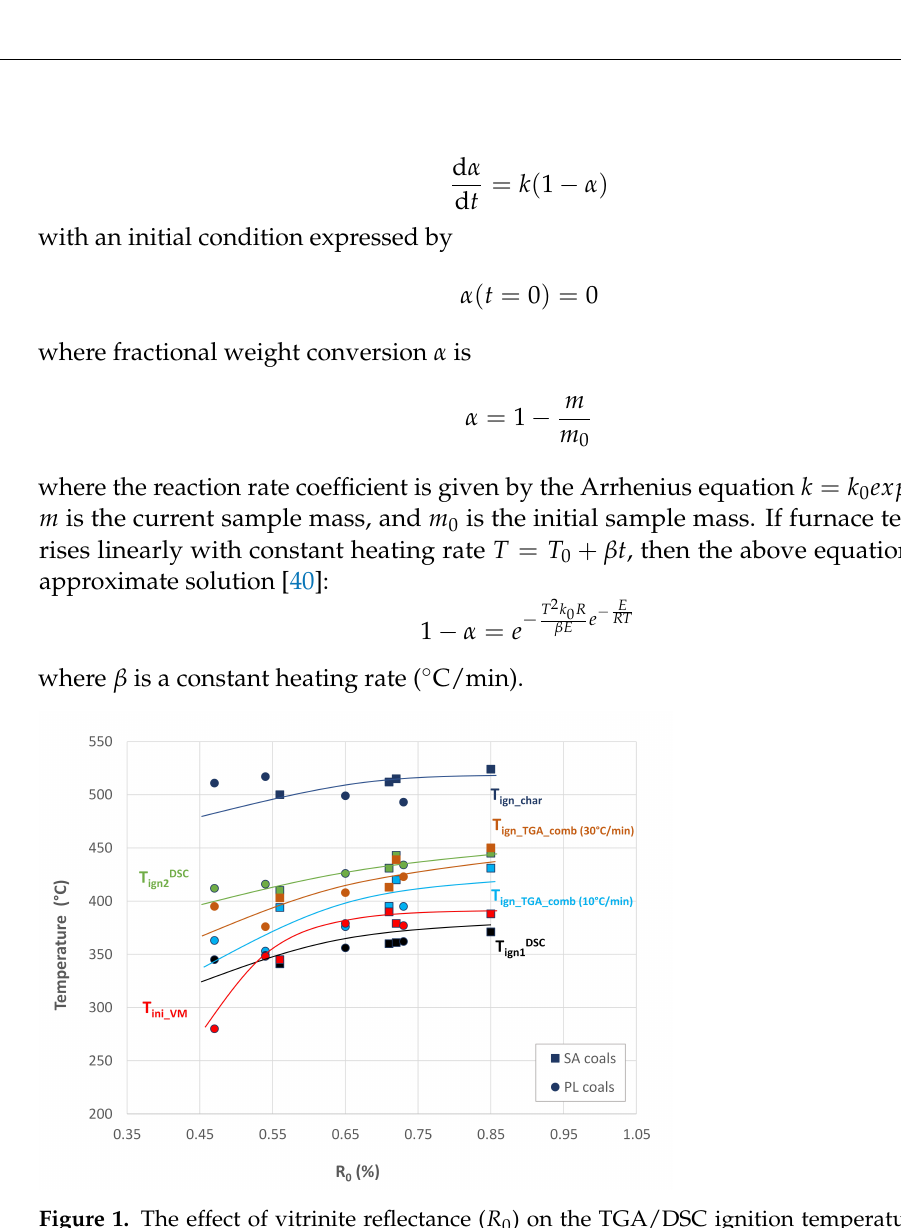
, T TGA ign comb ign char